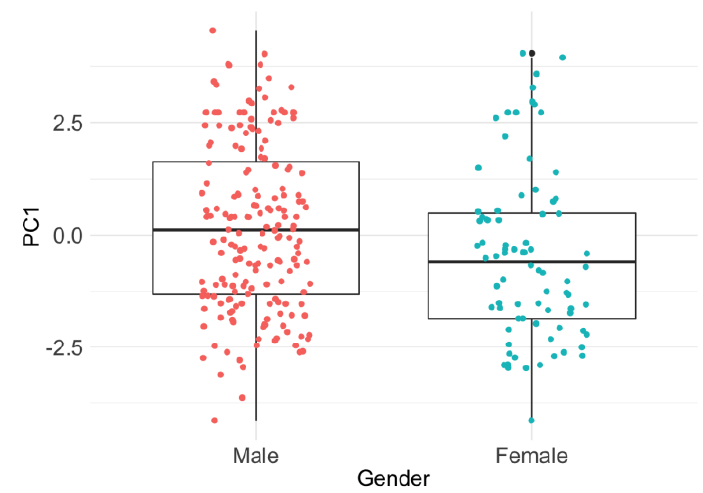
Figure 4. Boxplots of Principal Component 1 (PC1) loadings of attitudinal items for male and female respondents. Interpretation of the contributing PCA variables indicated that PC1 and attitudes towards animal welfare were negatively associated (more negative PC1 loadings for individuals reflecting more positive attitudes towards animal welfare).